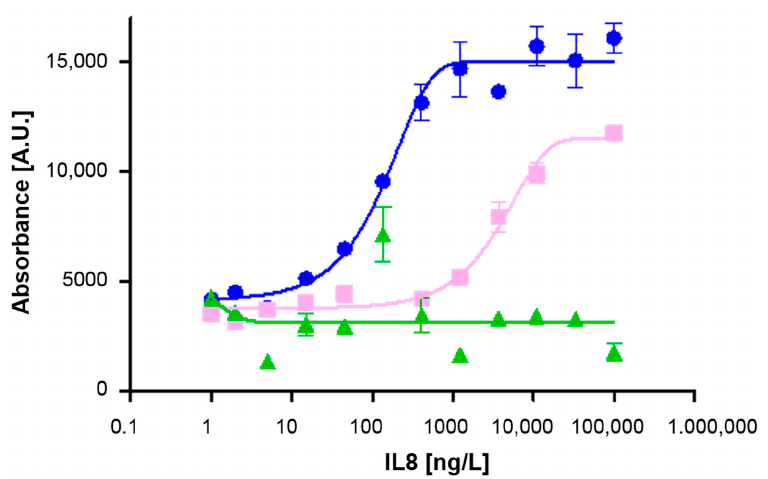
Figure 3. Mean readouts for marker IL8 using the enzymatic Assay Format (VI) in combination with different substrates: TMB1 ( ), TMB2 ( ), and ODI ( ). The blank (0 ng/L) is represented by 1 ng/L on the log scale.